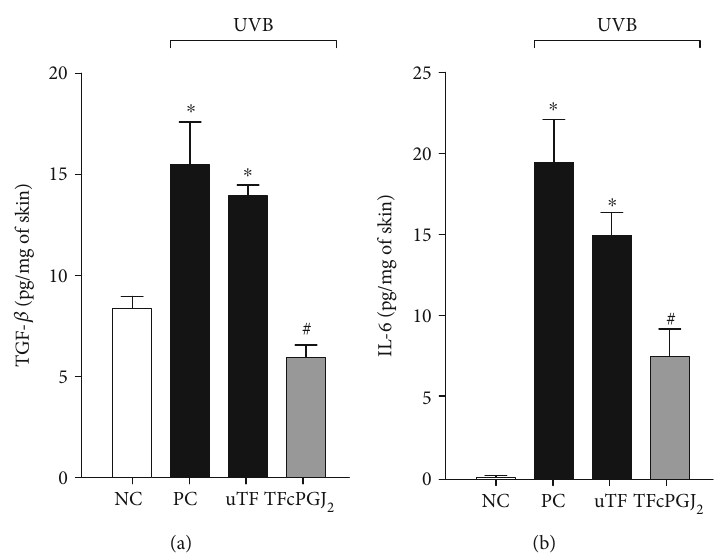
Figure 5: The UVB-triggered production of the cytokines was inhibited by topical formulation containing 15d-PGJ cytokines TGF- β (a) and IL-6 (b) were determined in skin samples collected 4h after the irradiation. NC: negative control; PC: positive control; uTF: unloaded topical formulation. Bars are means ± SEM of 6 mice per group and are representative of two separate experiments. One-way ANOVA followed by Tukey ’ s test. ∗ p < 0 : 05 versus the negative control group; # p < 0 : 05 versus UVB-stimulated